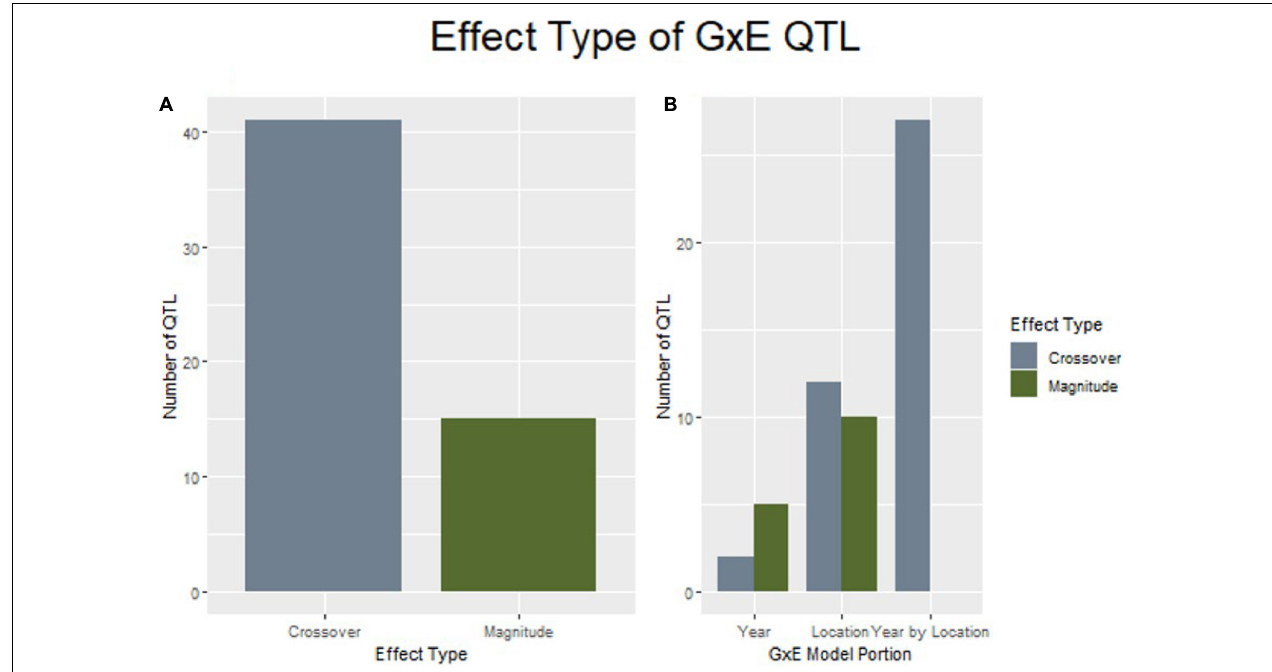
FIGURE 5 | QTL of the crossover effect type are more prevalent in this study than magnitude changes (A) , and are espeically common in the marker by year by location interaction (B) .